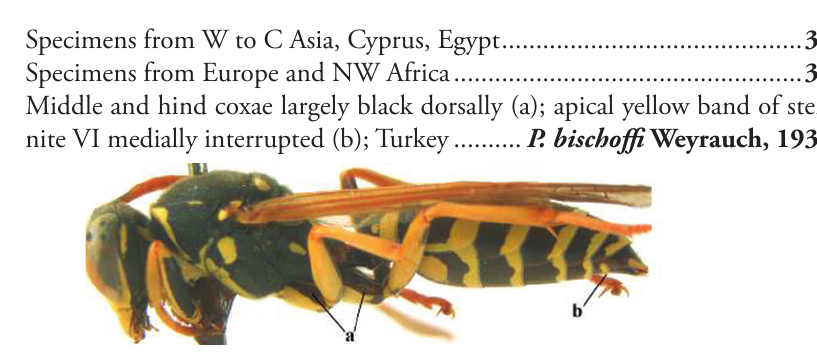
– Middle and hind coxae largely yellow dorsally (aa); apical yellow band of ster- nite VI medially continuous (bb); Cyprus, Turkey to Central Asia and Egypt ...